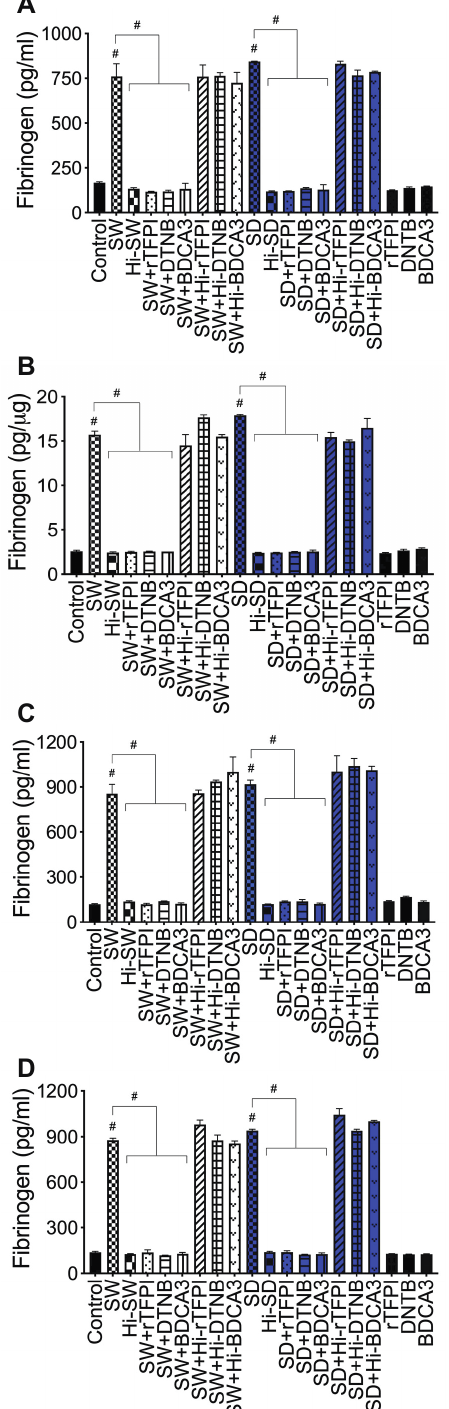
Figure 9. rTFPI, TM, and thiol blockers prevent S-proteins-induced fibrinogen expression and release in HLMEC: ( A , B ) HLMEC treated (24 h) with S-proteins (1 nM SW or SD), with or without rTFPI, DTNB, and BDCA3 (200 ng/mL); ( C ) HLMEC were treated 6 h with S-proteins, with or without rTFPI, DTNB, and BDCA3, washed, and co-cultured with neutrophils for 24 h; ( D ) human neutrophils were treated 6 h with S-proteins, with or without rTFPI, DTNB, and BDCA3, washed, and co-cultured with HLMEC for 24 h. Following treatments, fibrinogen levels in culture supernatants ( A , C , D ) and endothelial cell lysates ( B ) were quantified by ELISA. Data presented as mean ± standard deviation. Control: untreated cells; Hi: heat-inactivated (SW, SD, rTFPI, DTNB, BDCA3). # p <